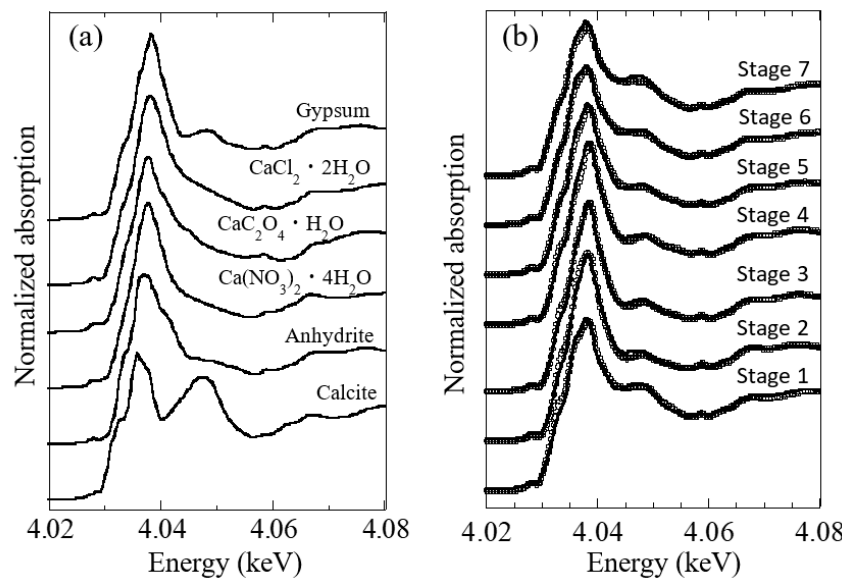
Figure 4. XANES spectra at Ca K-edge for ( a ) Ca reference materials and ( b ) Ca in size-fractionated aerosol samples. Circles and solid curves in ( b ) showed measured spectra and spectra obtained by LCF analysis, respectively.